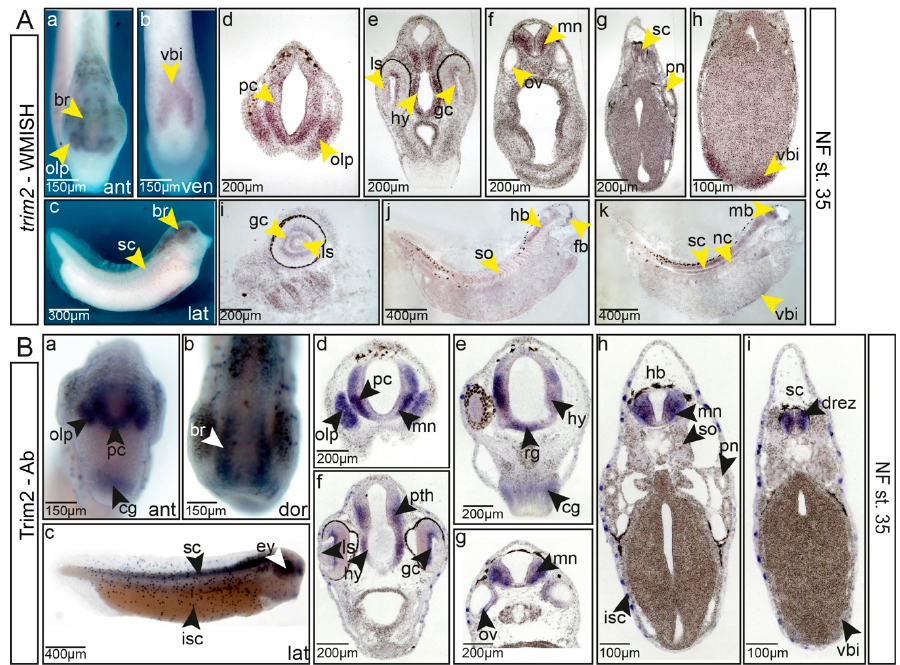
Figure 2. Trim2/ trim2 are expressed in differentiated neurons of the forming central nervous system Figure 2. Trim2 / trim2 are expressed in di ff erentiated neurons of the forming central nervous system at the tailbud stage. ( A ) (a–c) Expression of trim2 mRNA at NF stage 35, anterior, ventral, and lateral views, trim2 transcripts were detected in the forming brain (br), olfactory pit (olp), spinal cord (sc), and the ventral blood island (vbi). (d–h) Twenty-micrometer gelatine / albumin sections at the level of fore-, mid-, hindbrain, and spinal cord. trim2 is expressed in the prosencephalon (pc), olfactory pit, ganglion cell layer (gc), lens epithelium (ls), hypothalamus (hy), motor neurons (mn), otic vesicle (ov), and spinal cord (sc). Faint expression was observed in the ventral blood island. (i–k) Sagittal sections reveal trim2 expression in the ganglion cell layer, lens epithelium, brain, spinal cord, notochord (nc), somites (so), and ventral blood island. ( B ) Whole-mount immunochemistry. (a–c) At NF stage 35 (anterior, dorsal, and lateral views), Trim2 protein expression overlaps strongly with trim2 mRNA. (d–i) Twenty-micrometer gelatine / albumin transverse sections along the fore-, mid-, hindbrain, and spinal cord region. Trim2 protein was detected in the developing CNS, cement gland, dorsal root entry zone (drez), ganglion cells, hindbrain, hypothalamus, ion-secreting cells (isc), motor neurons, olfactory pit, otic vesicle, prosencephalon (pc), prethalamus (pth), presumptive radial glial cells (rg), somites (so), and ventral blood